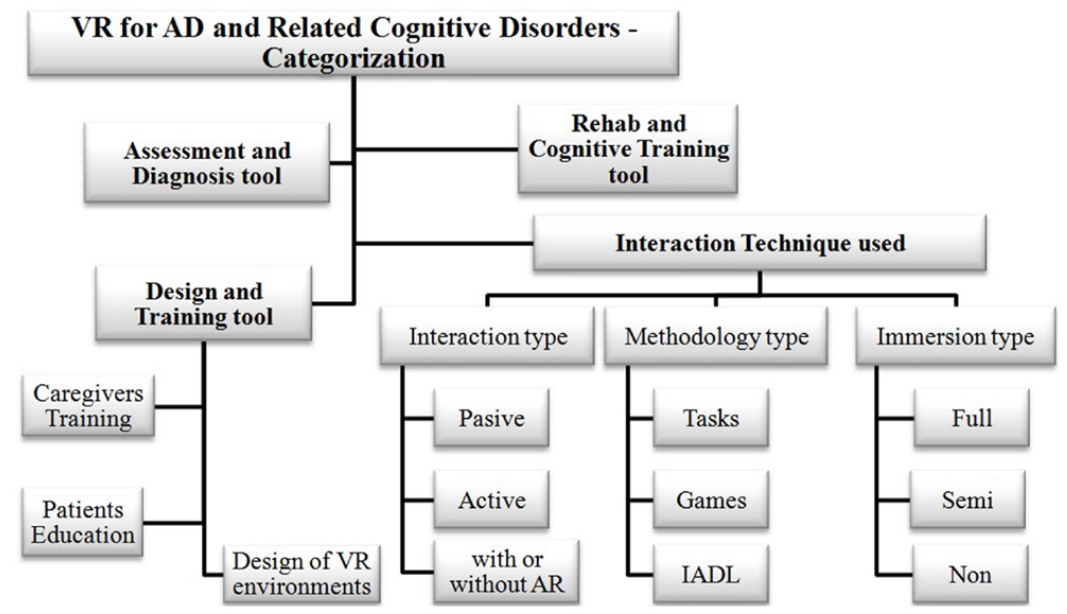
Figure 3. Garcia-Betances et al.’s [61] categorization of applications for Alzheimer Disease (AD) using Virtual Reality